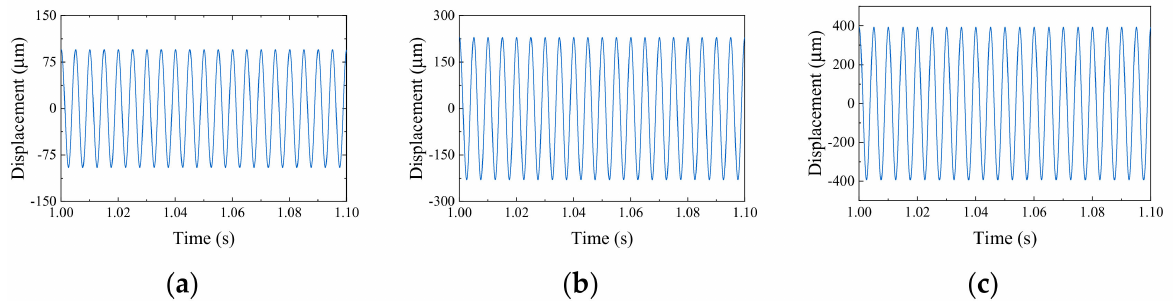
Figure 6. Imbalanced and static eccentric coupling faults: ( a ) value of imbalance 20 × 10 − 5 kg · m; ( b ) value of imbalance 100 × 10 − 5 kg · m; ( c ) value of imbalance 200 × 10 − 5 kg ·